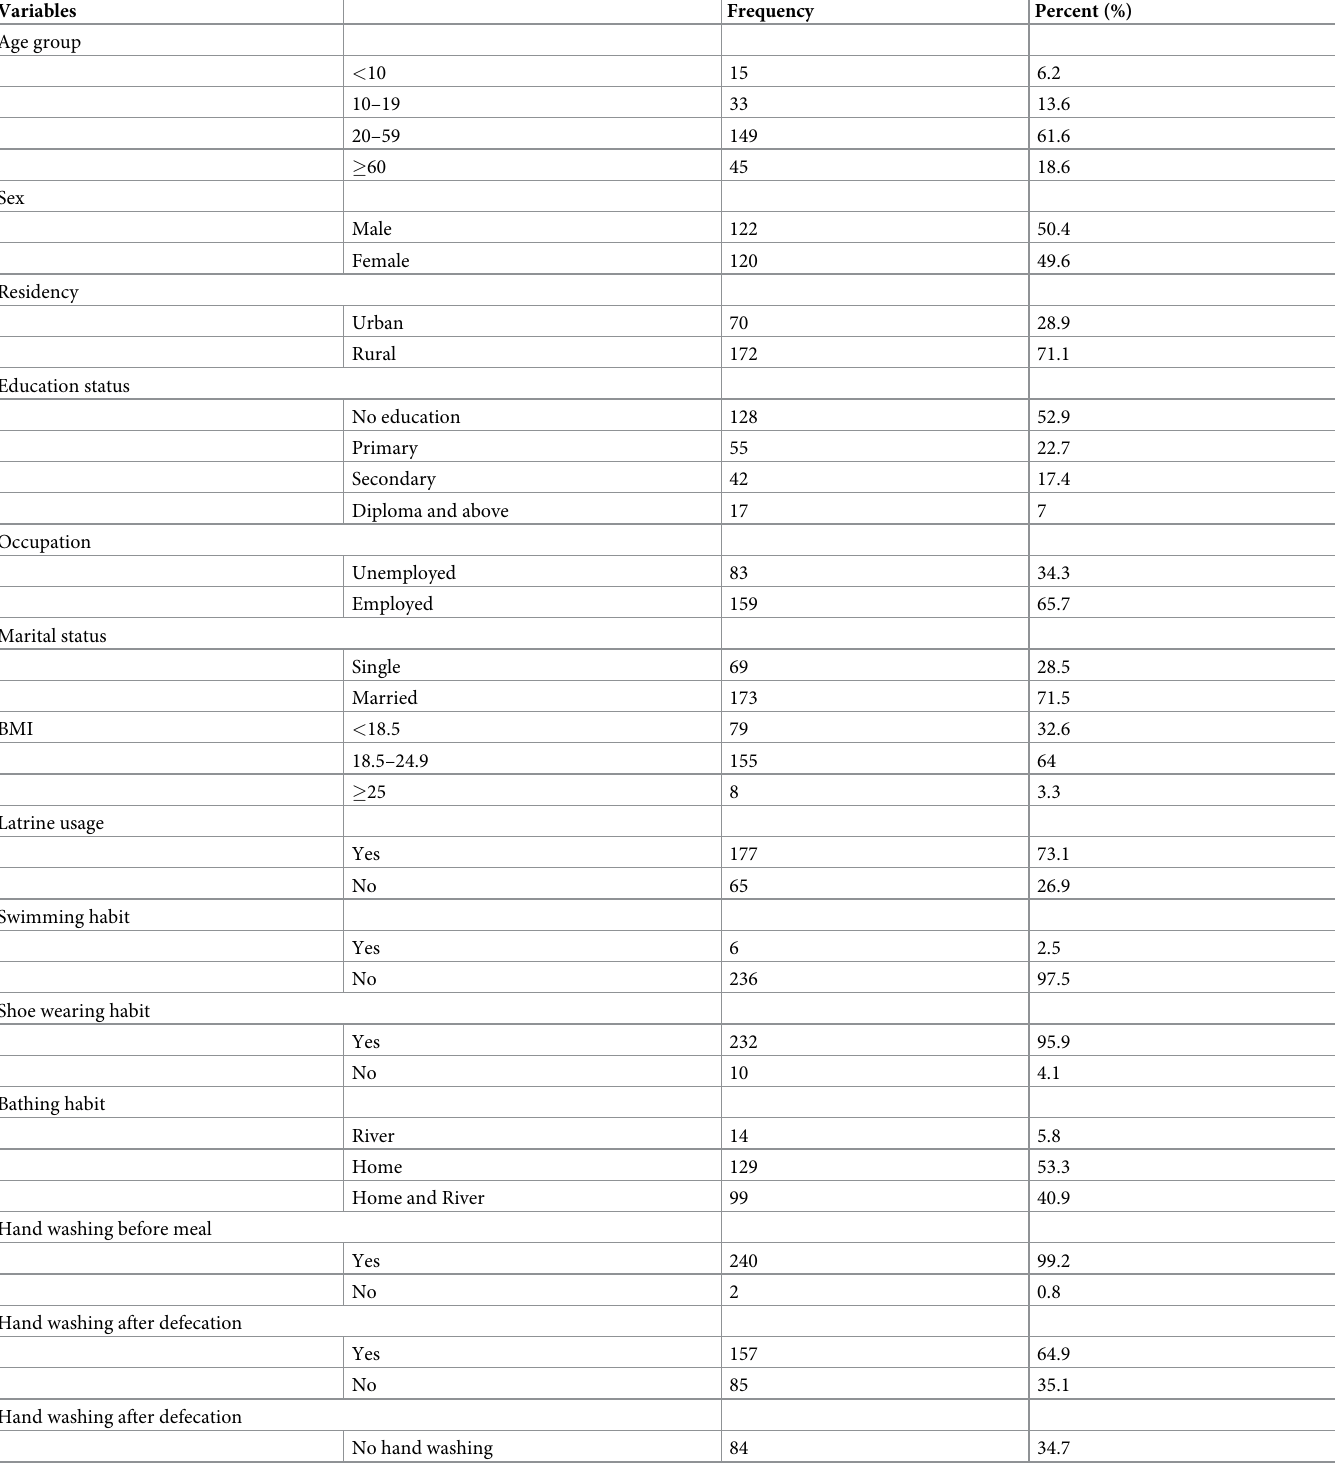
Table 1. Socio-demographic and behavioral characteristics of the PTB suspected patients attending Kuyu General Hospital, North Shewa, Oromia, Ethiopia, 2020 (n =